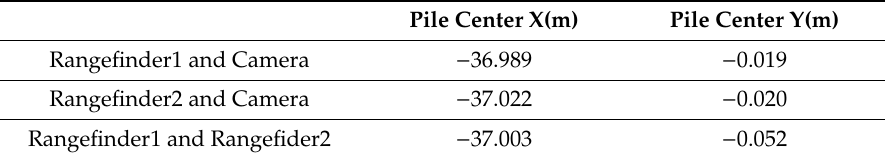
Table 5. Calculated results of three combinations.